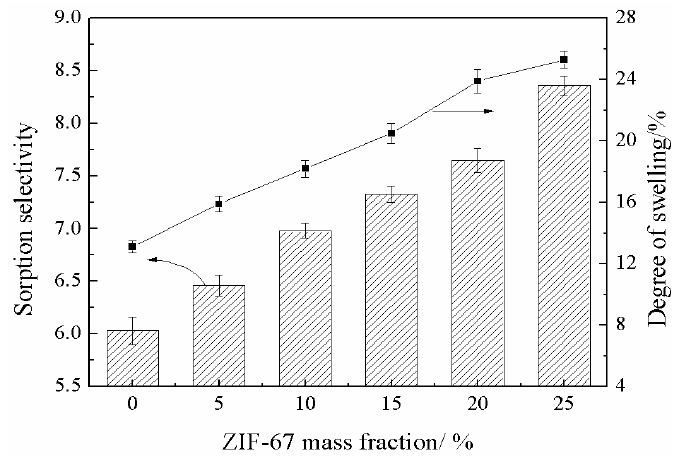
Figure 9. Sorption selectivity and degree of swelling of mixed matrix membranes.